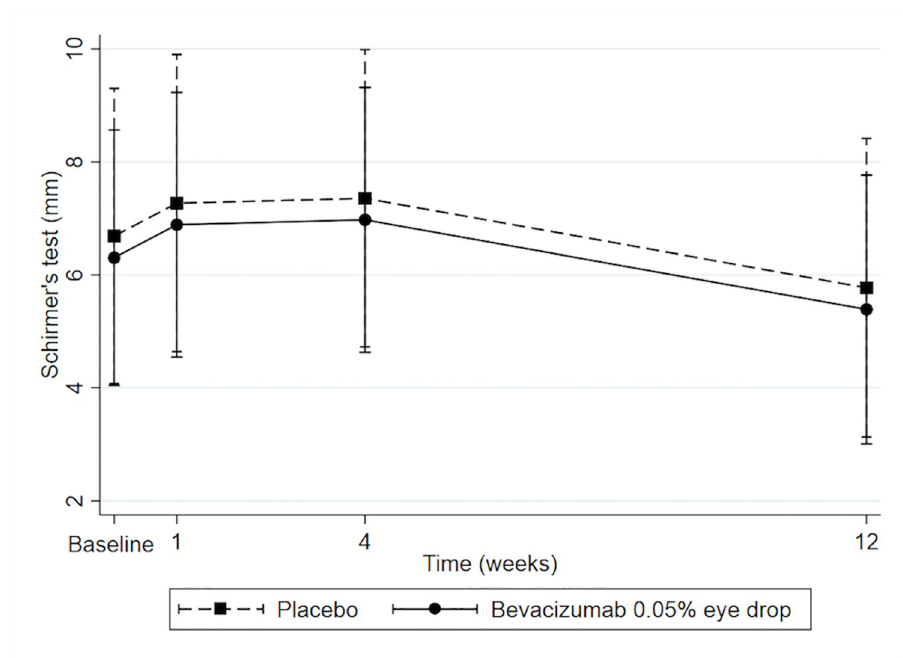
Fig 5. Predicted Schirmer test with 95% confidence intervals.